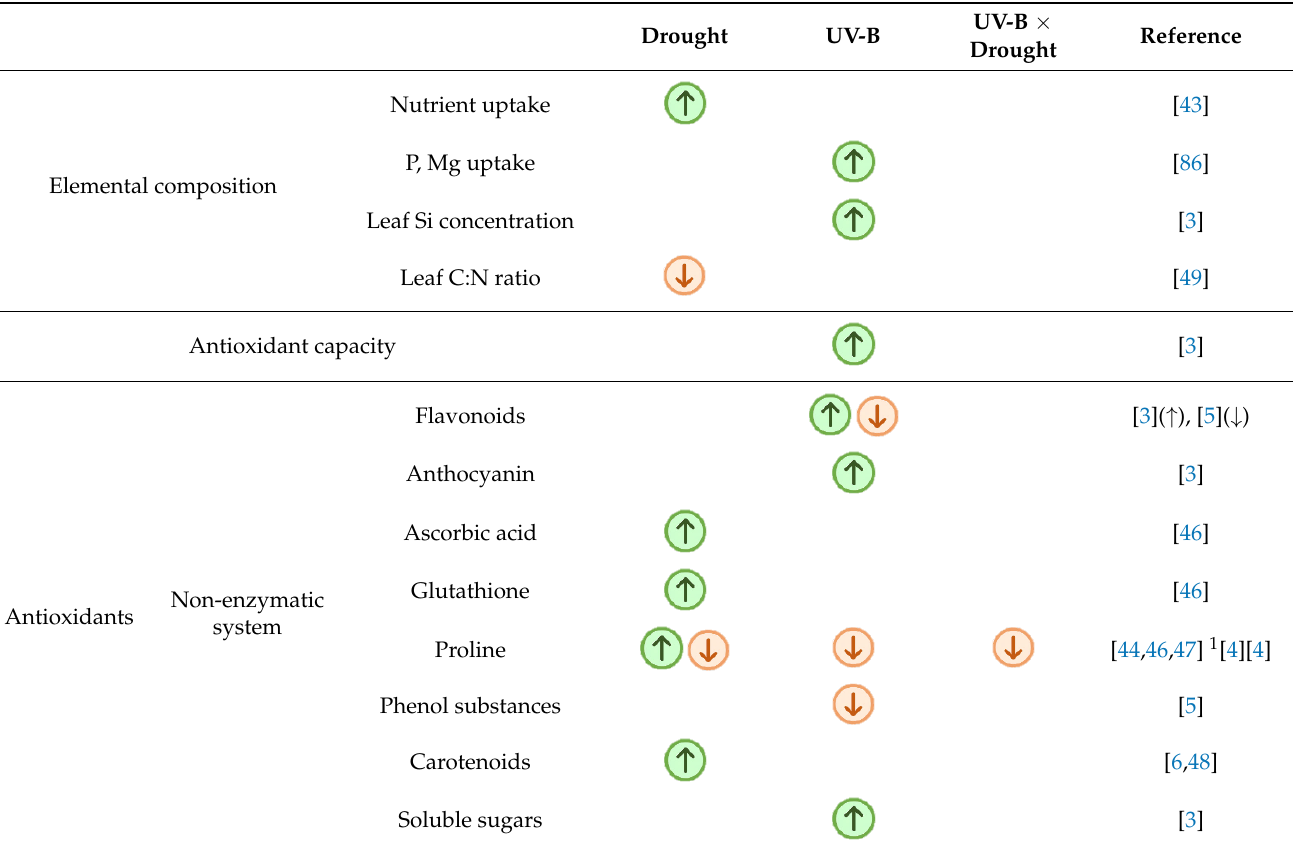
free proline levels and H 2 O 2 concentrations, compared to the nontreated plants [4]. Table 3. Effects of silicon supplementation on the measured parameters in the presence of UV-B, drought and their combination as revised from the literature. Arrows indicate increases ( ↑ ) or de- creases ( ↓ ) of each parameter under UV-B, drought, or combined stress conditions (UV-B × drought) Table 3. Effects of silicon supplementation on the measured parameters in the presence of UV-B, Table 3. Effects of silicon supplementation on the measured parameters in the presence of UV-B, in silicon treated plants. drought and their combination as revised from the literature. Arrows indicate increases ( ↑ ) or de- drought and their combination as revised from the literature. Arrows indicate increases ( ↑ ) or de- creases ( ↓ ) of each parameter under UV-B, drought, or combined stress conditions (UV-B × drought) Table 3. Effects of silicon supplementation on the measured parameters in the presence of UV-B, creases ( ↓ ) of each parameter under UV-B, drought, or combined stress conditions (UV-B × drought) in silicon treated plants. drought and their combination as revised from the literature. Arrows indicate increases ( ↑ ) or de- As summarized on Table 3, Si addition to UV-B and drought stress reduces membrane in silicon treated plants. creases ( ↓ ) of each parameter under UV-B, drought, or combined stress conditions (UV-B × drought) damage, oxidative stress and levels of some antioxidants or antioxidant enzymes activities. in silicon treated plants. Table 3. Effects of silicon supplementation on the measured parameters in the presence of UV-B, Table 3. Effects of silicon supplementation on the measured parameters in the presence of UV-B, drought and their combination as revised from the literature. Arrows indicate increases ( ↑ ) or de- drought and their combination as revised from the literature. Arrows indicate increases ( ↑ ) or de- creases ( ↓ ) of each parameter under UV-B, drought, or combined stress conditions (UV-B × drought) creases ( ↓ ) of each parameter under UV-B, drought, or combined stress conditions (UV-B × drought) in silicon treated plants. Table 3. Effects of silicon supplementation on the measured parameters in the presence of UV- Table 3. Effects of silicon supplementation on the measured parameters in the presence of UV-B, in silicon treated plants. drought and their combination as revised from the literature. Arrows indicate increases ( ↑ ) or de- B, drought and their combination as revised from the literature. Arrows indicate increases ( ↑ ) or creases ( ↓ ) of each parameter under UV-B, drought, or combined stress conditions (UV-B × drought) Table 3. Effects of silicon supplementation on the measured parameters in the presence of UV-B, decreases ( ↓ ) of each parameter under UV-B, drought, or combined stress conditions (UV-B × drought) in silicon treated plants. drought and their combination as revised from the literature. Arrows indicate increases ( ↑ ) or de- in silicon treated plants. creases ( ↓ ) of each parameter under UV-B, drought, or combined stress conditions (UV-B × drought) Table 3. Effects of silicon supplementation on the measured parameters in the presence of UV-B, Table 3. Effects of silicon supplementation on the measured parameters in the presence of UV-B, Table 3. Effects of silicon supplementation on the measured parameters in the presence of UV-B, Table 3. Effects of silicon supplementation on the measured parameters in the presence of UV-B, in silicon treated plants. drought and their combination as revised from the literature. Arrows indicate increases ( ↑ ) or de- drought and their combination as revised from the literature. Arrows indicate increases ( ↑ ) or de- drought and their combination as revised from the literature. Arrows indicate increases ( ↑ ) or de- drought and their combination as revised from the literature. Arrows indicate increases ( ↑ ) or de- creases ( ↓ ) of each parameter under UV-B, drought, or combined stress conditions (UV-B × drought) Table 3. Effects of silicon supplementation on the measured parameters in the presence of UV-B, Table 3. Effects of silicon supplementation on the measured parameters in the presence of UV-B, creases ( ↓ ) of each parameter under UV-B, drought, or combined stress conditions (UV-B × drought) creases ( ↓ ) of each parameter under UV-B, drought, or combined stress conditions (UV-B × drought) creases ( ↓ ) of each parameter under UV-B, drought, or combined stress conditions (UV-B × drought) in silicon treated plants. drought and their combination as revised from the literature. Arrows indicate increases ( ↑ ) or de- drought and their combination as revised from the literature. Arrows indicate increases ( ↑ ) or de- in silicon treated plants. in silicon treated plants. in silicon treated plants. creases ( ↓ ) of each parameter under UV-B, drought, or combined stress conditions (UV-B × drought) Table 3. Effects of silicon supplementation on the measured parameters in the presence of UV-B, creases ( ↓ ) of each parameter under UV-B, drought, or combined stress conditions (UV-B × drought) in silicon treated plants. drought and their combination as revised from the literature. Arrows indicate increases ( ↑ ) or de- in silicon treated plants. creases ( ↓ ) of each parameter under UV-B, drought, or combined stress conditions (UV-B × drought) in silicon treated plants. Table 3. Effects of silicon supplementation on the measured parameters in the presence of UV-B, drought and their combination as revised from the literature. Arrows indicate increases ( ↑ ) or de- creases ( ↓ ) of each parameter under UV-B, drought, or combined stress conditions (UV-B × drought) Table 3. Effects of silicon supplementation on the measured parameters in the presence of UV-B, in silicon treated plants. drought and their combination as revised from the literature. Arrows indicate increases ( ↑ ) or de- creases ( ↓ ) of each parameter under UV-B, drought, or combined stress conditions (UV-B × drought) in silicon treated